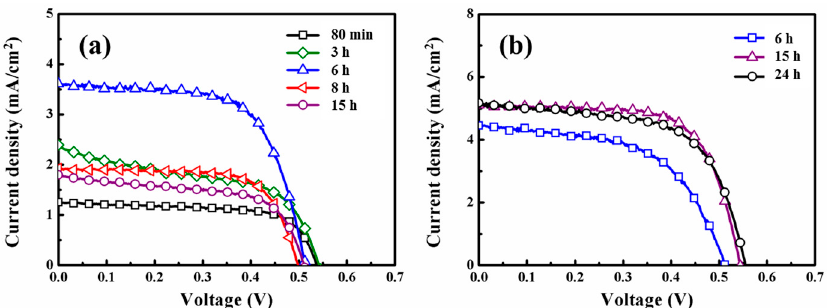
Figure 2. J–V curves of YD2-o-C8-sensitized ZnO dye-sensitized solar cells (DSSCs) with photoanodes fabricated with different sensitization periods in ( a ) ethanol solution of 0.4 mM YD2-o-C8; and ( b ) ethanol solution of 0.1 mM YD2-o-C8 and 0.5 mM chenodeoxycholic acid (CDCA) at room temperature (RT).